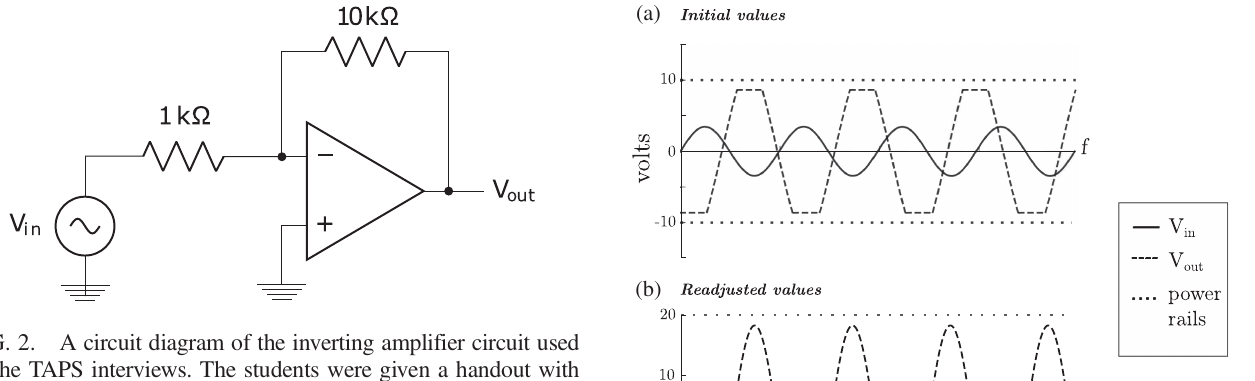
, the clipping in